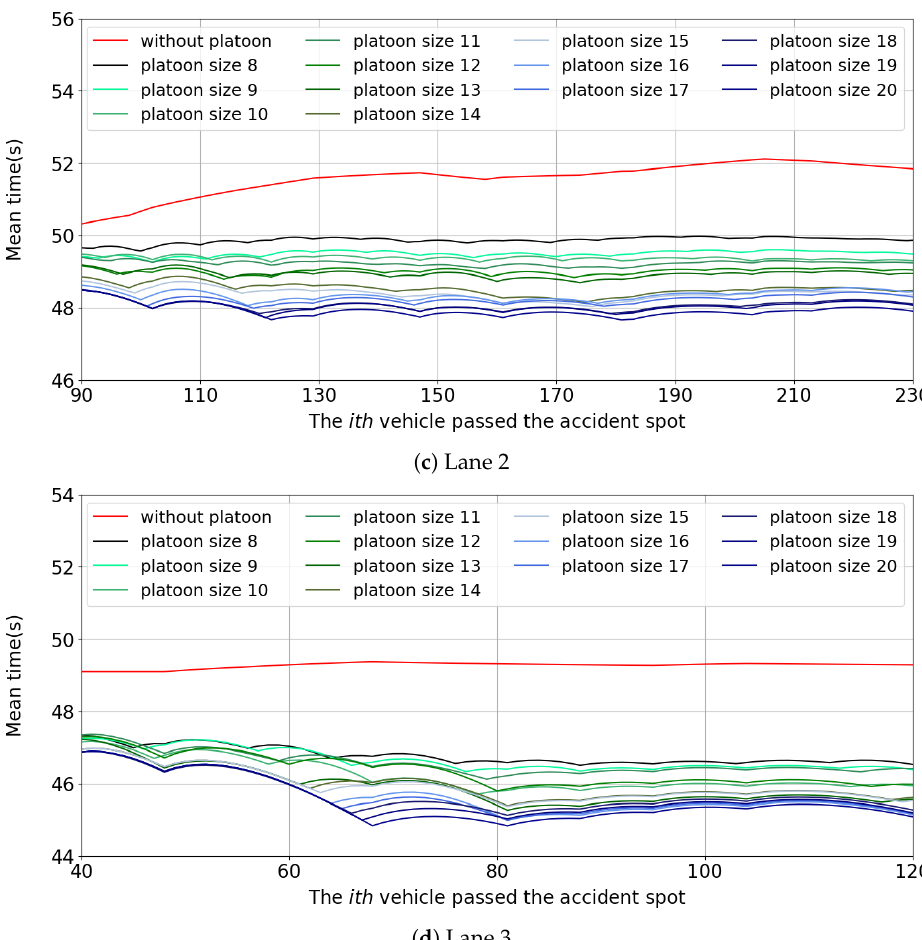
Figure 8. The mean time taken for the vehicles to exit the congestion spot if they receive an accident warning 1500 m ahead of the accident